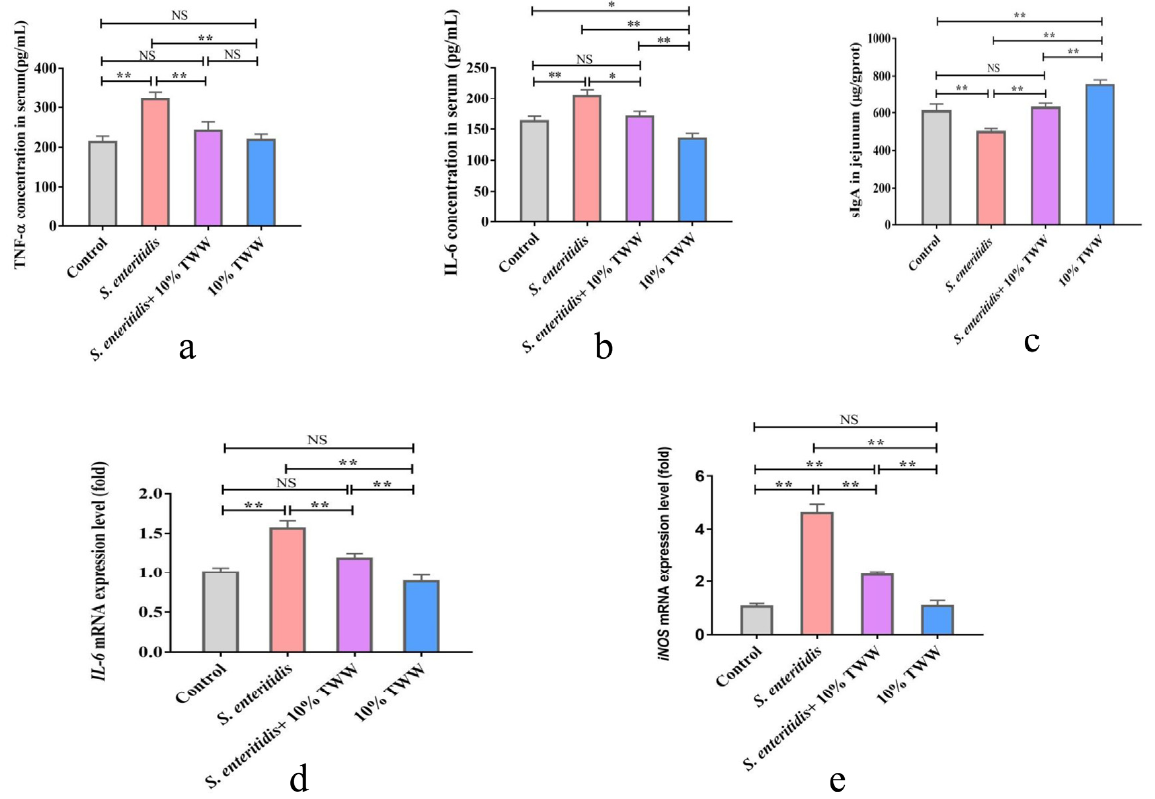
Figure 6. TWW improves the immune function in S. enteritidis -infected chickens. ( a , b ) Tumor necrosis factor- α (TNF- α ) and interleukin-6 (IL-6) contents in serum. ( c ) Secretory IgA (sIgA) content in jejunum tissues. ( d , e ) The mRNA level of interleukin-6 (IL-6) and inducible nitric oxide synthase (iNOS). Values presented as means ± SEM. * p < 0.05, ** p < 0.01, compared between the indicated groups. NS: no significance between the indicated groups.